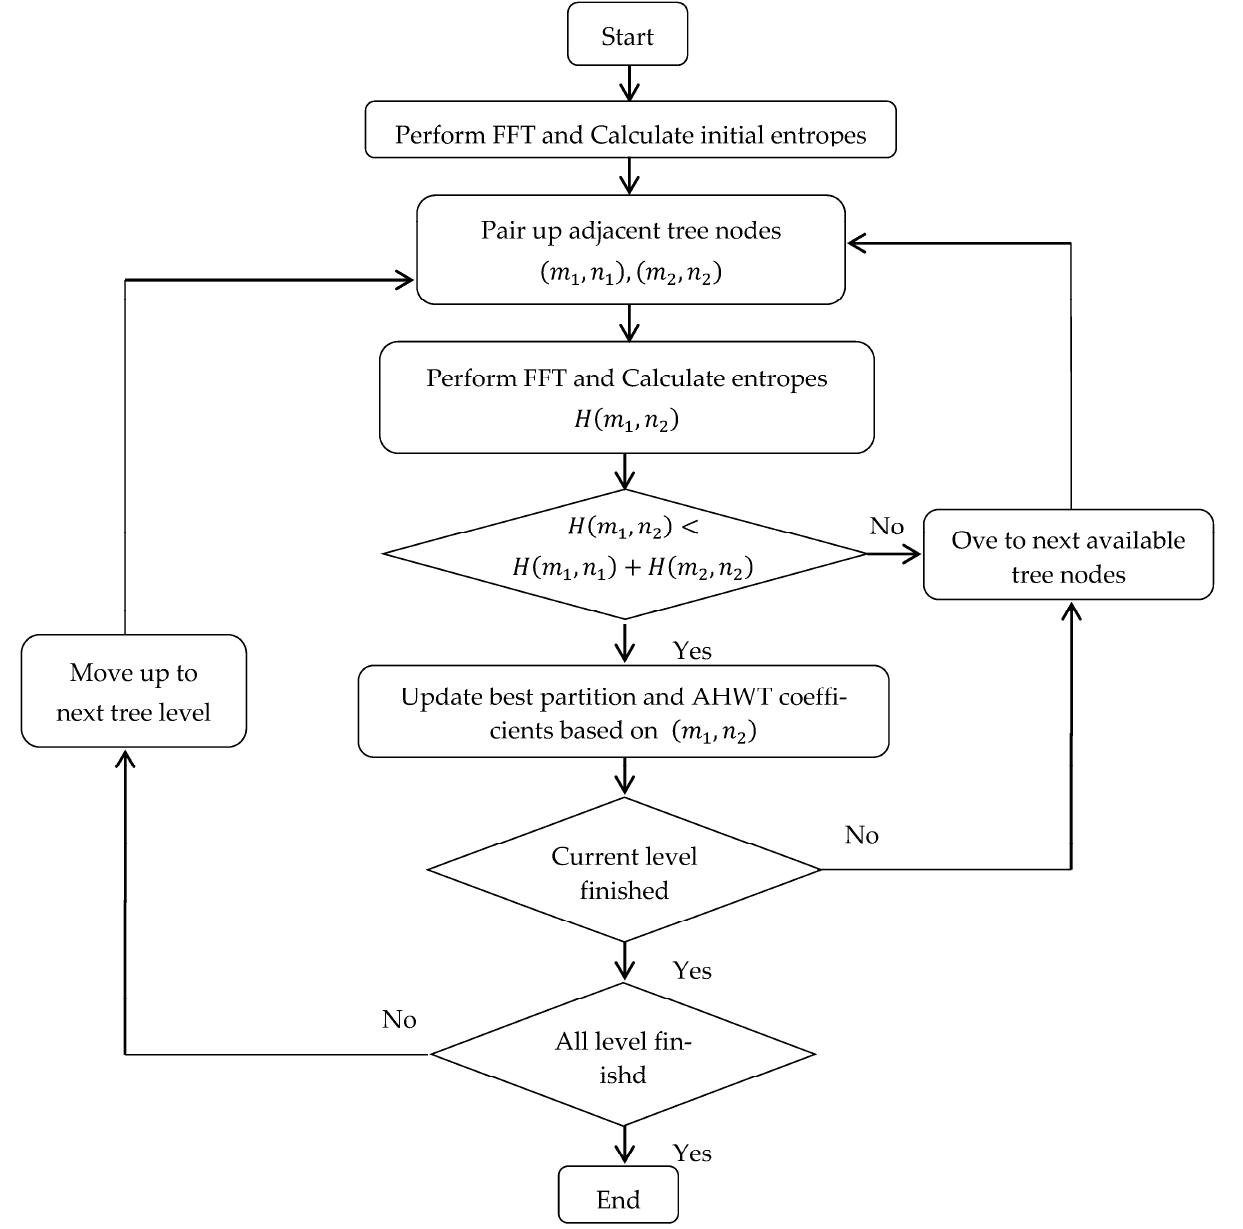
Figure 10. Flow chart of the iterative searching algorithm.